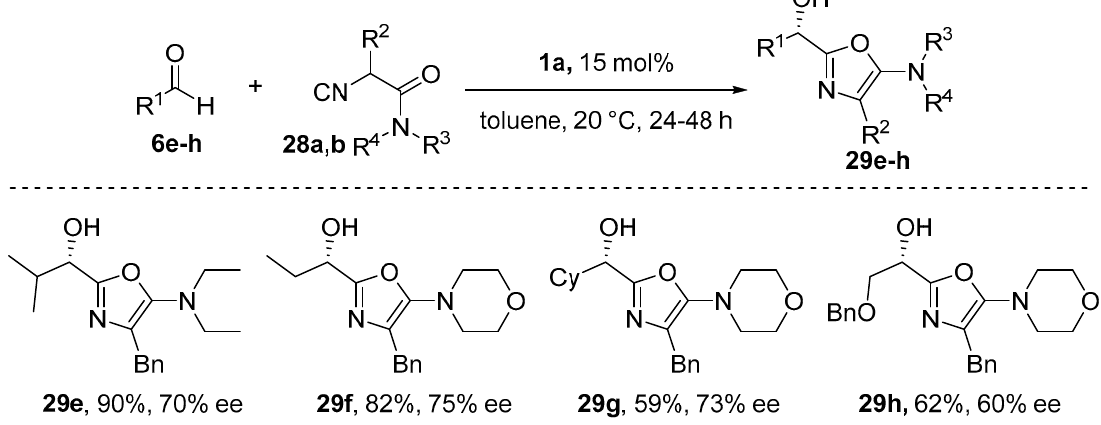
Figure 8. Proposed mechanism in the reaction of isocyanides with aldehydes.